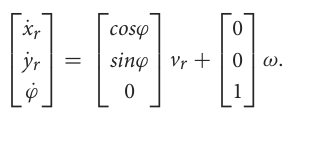
where L is the wheelbase of the